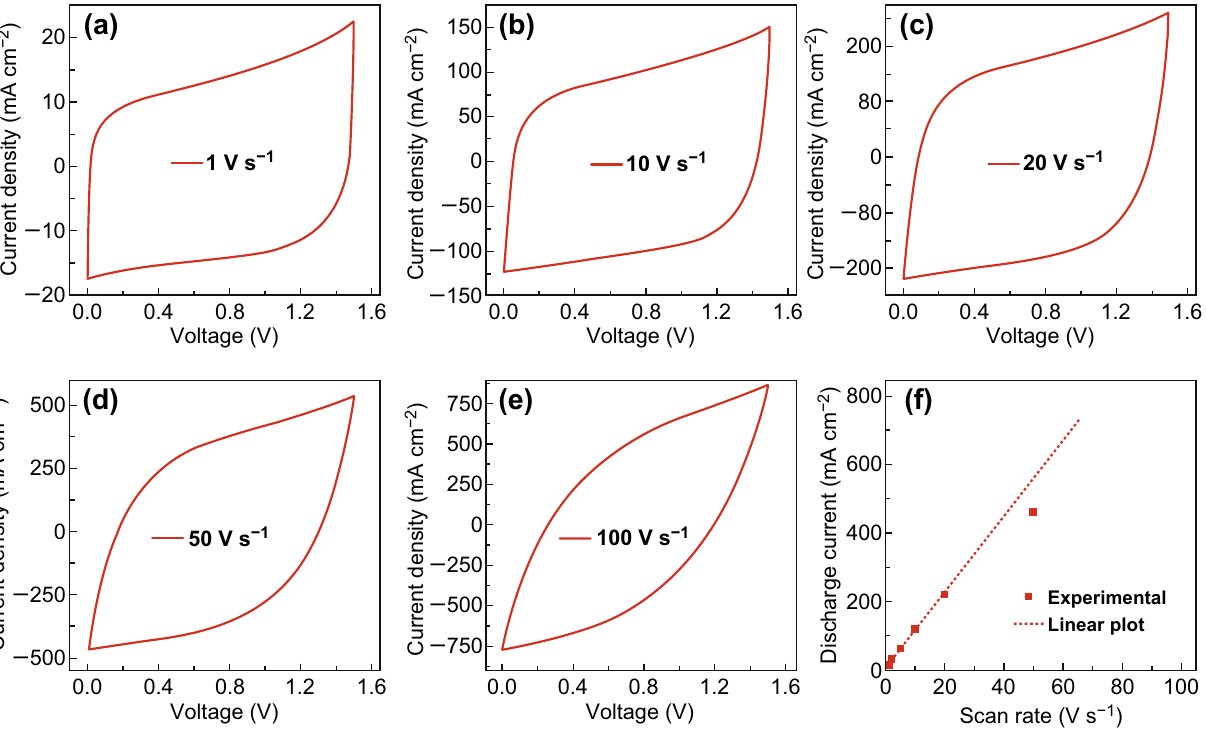
Fig. 5 a – e CV curves of TiN paper SSC collected at different scan rates in 0.5 M Na 2 SO 4 aqueous electrolyte. f A plot of discharge current of TiN paper SSC against scan